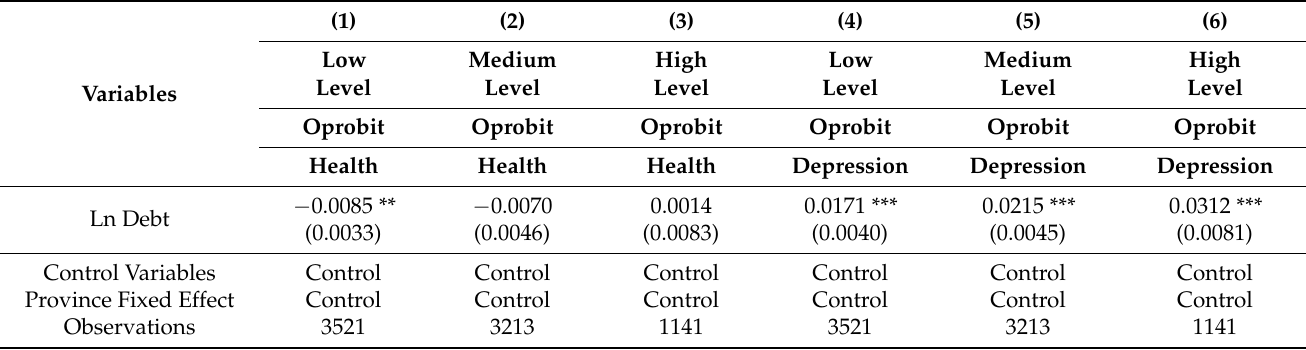
Table 9. Heterogeneity analysis results (education differences).